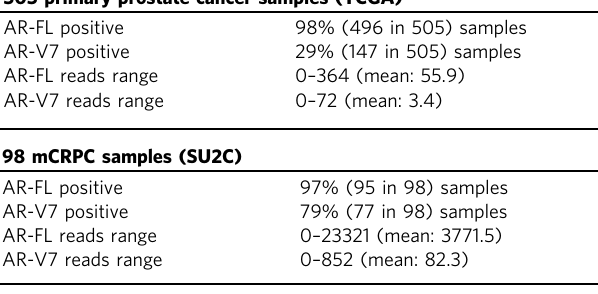
Table 1 Transcript expression in patients with mCRPC.